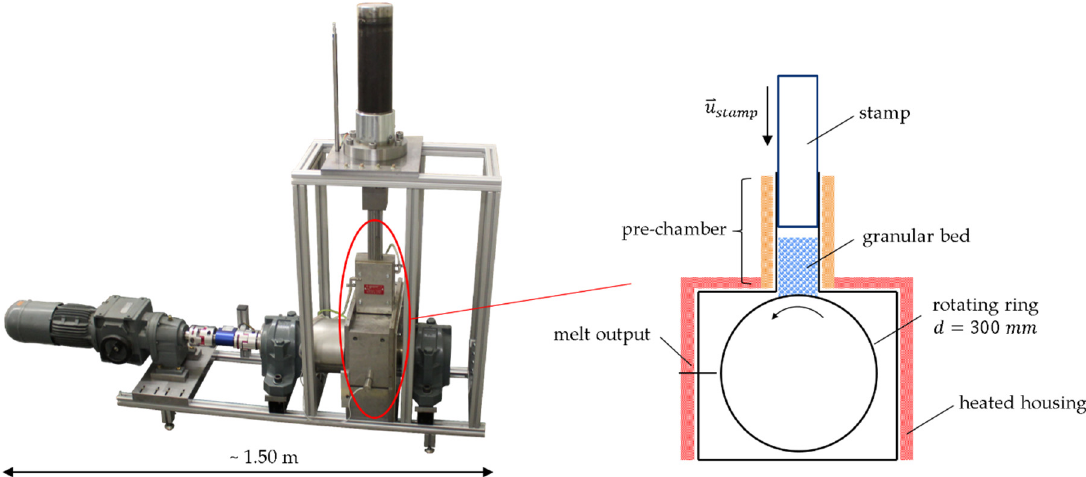
Figure 3. Melting apparatus and principle of operation.